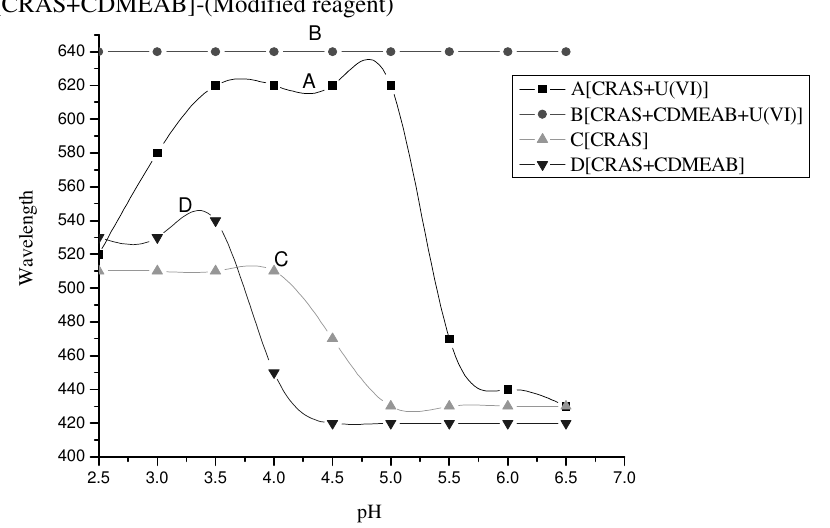
Figure 3. Variations in λ with changes in the pH of: A) [CRAS+Th(IV)]-(Binary max complex); B) [CRAS+CDMEAB+Th(IV)]-(Ternary complex); C) [CRAS]-(Reagent) and D [CRAS+CDMEAB]-(Modified reagent)